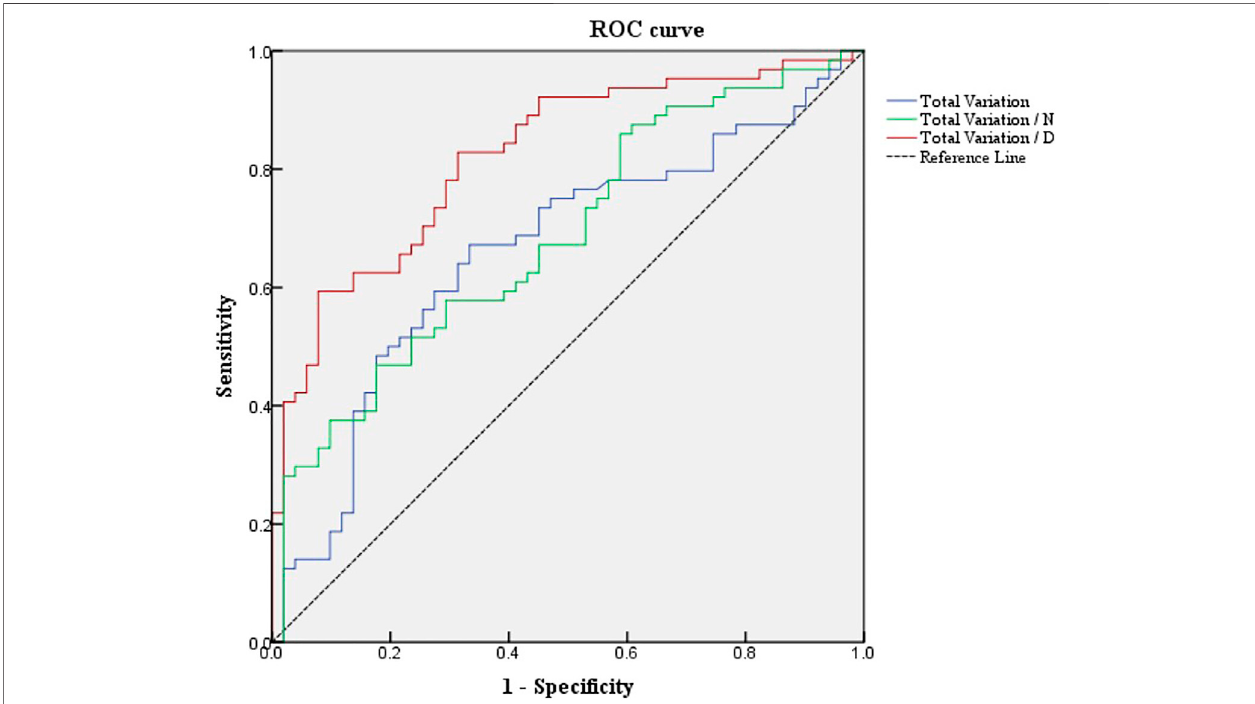
FIGURE 3 | ROC curves of total variation and Uneven indexes differentiate Demodex blepharitis subjects from the normal controls. ROC, receiver operating characteristic; Total variation/N, total variation/the number of MGs; Total variation/D, total variation/MG density.